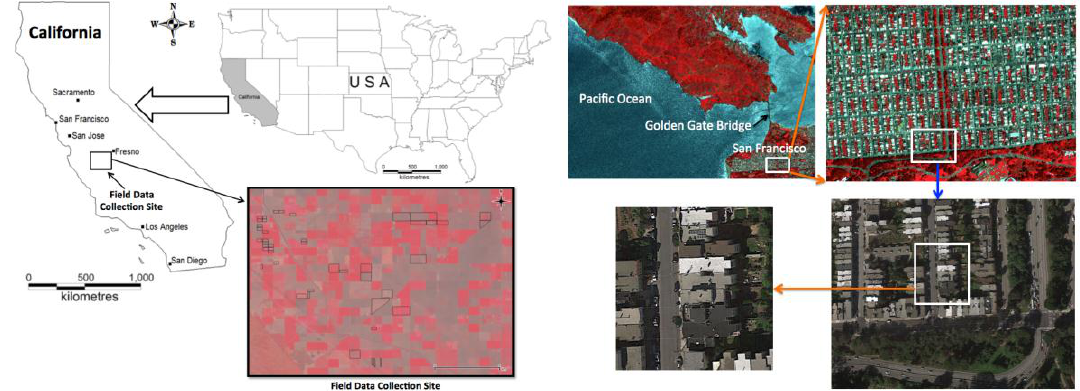
Figure 1. Field data collection site in the San Joaquin Valley, central California, with surveyed boundaries (black polygons) from which ground fractional cover were derived for validation ( left ). Part of San Francisco city with a mix of substrate, vegetation, roads, shadow and dark objects ( right ).